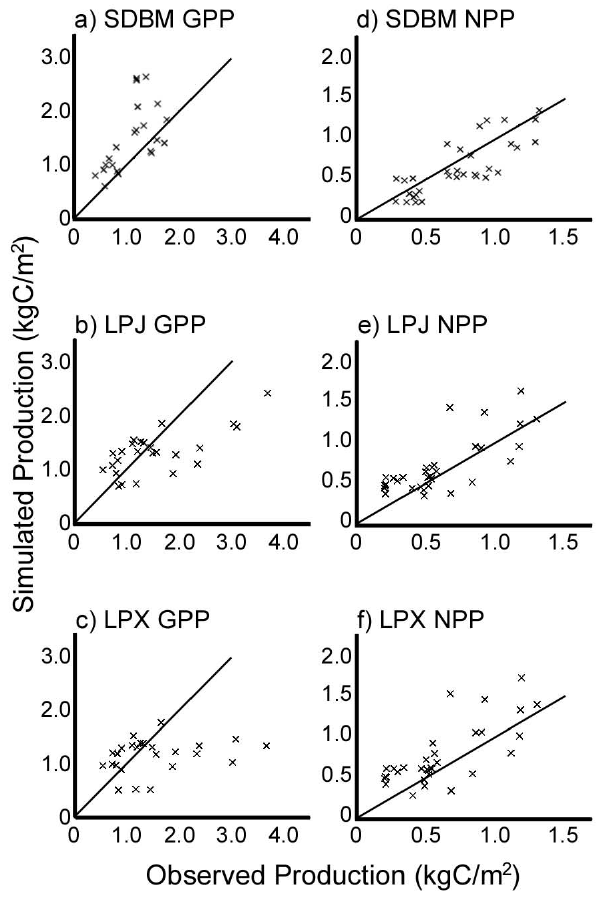
Fig. 5. Comparisons of observed and simulated NPP and GPP in kgCm − 2 . The NPP observations (x-axis) are from the dataset made by combining sites from the Luyssaert et al. (2007) dataset and the Ecosystem/Model Data Intercomparison dataset (Olson et al., 2001). The GPP observations are derived from the Luyssaert et al. (2007) dataset. The simulated values (y-axis) are annual aver- ages for the period 1998–2005. The observations are compared with NPP (a) and GPP (b) from the Simple Diagnostic Biosphere Model (SDBM), NPP (c) and GPP (d) from LPJ and NPP (e) and GPP (f) from LPX. The solid line shows the 1:1 relationship.